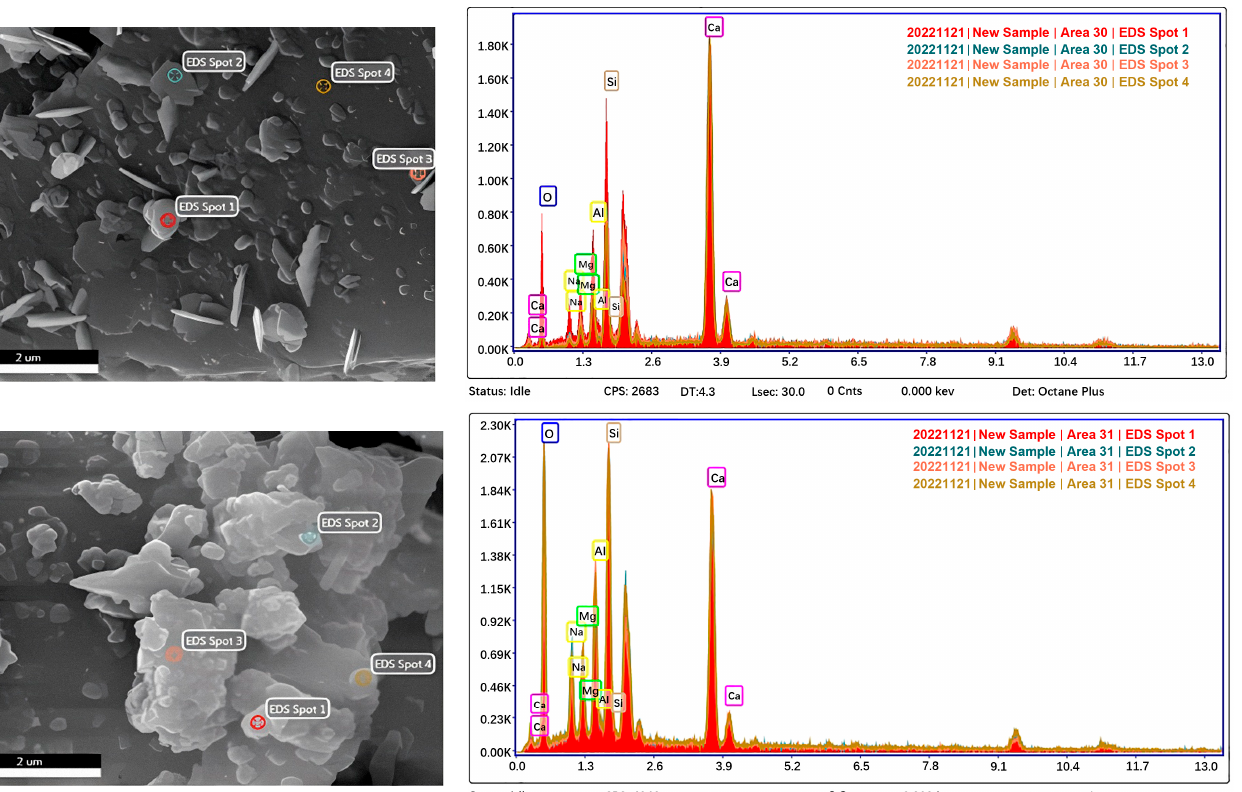
Figure 9. EDS images of B2 and B6.